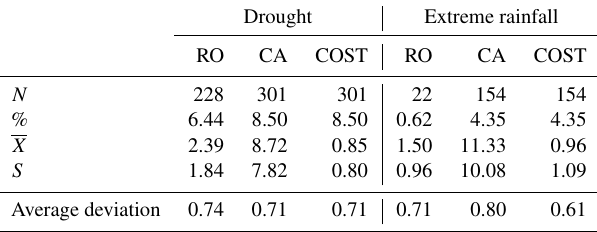
Table 1. Basic statistics of the reconstructed series by the three methods for both droughts and extreme rainfall, respectively. N refers to the number of months where the series differs from zero during the 1600–1900 period, excluding data gaps (1820–1823 and 1891–1892). Percentage (%) indicates the fraction of months in- cluding an event. X and S represent the mean and standard devia- tion of the series, respectively. The average deviation is a dispersion metric calculated as the average of the absolute difference between a given month and the mean of the